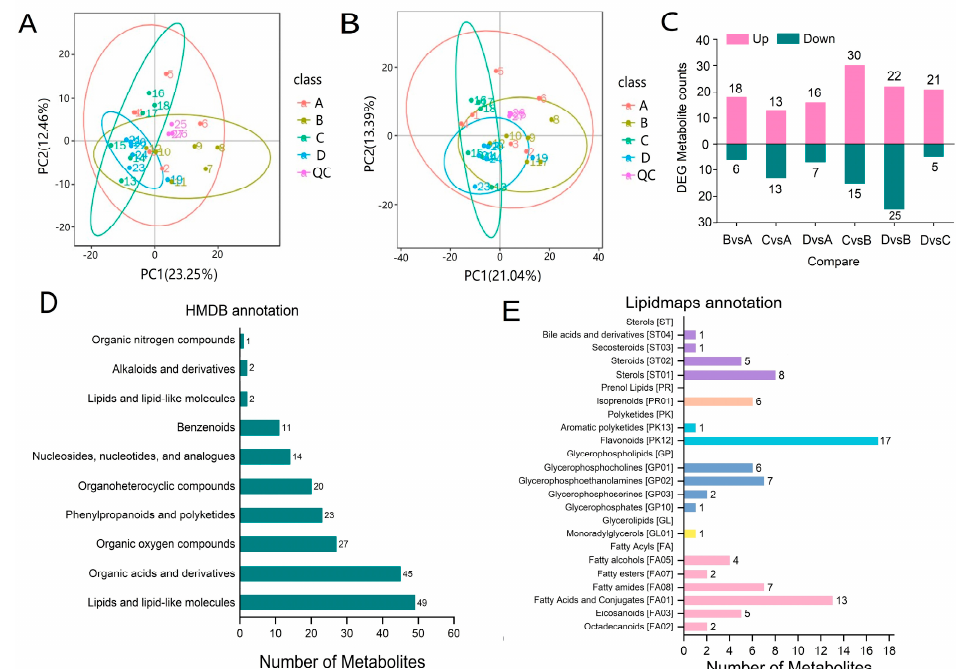
Figure 5. Identification of metabolites of asparagus under shading treatment. ( A ) PCA in negative ion modes. ( B ) PCA in positive ion modes. ( C ) Metabolites change under different shading treatments. ( D ) Metabolites classified by HMDB database. ( E ) Metabolites classified by lipid profile database.